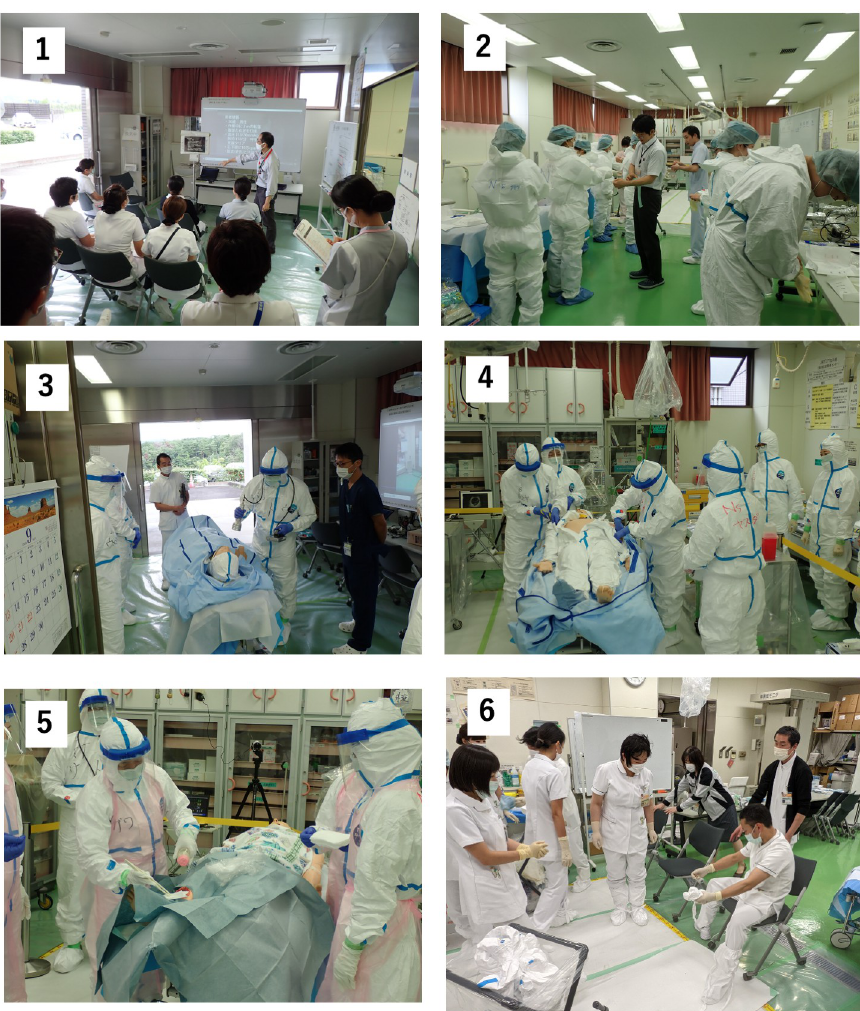
Fig 2. Seminar image of each process. (1) Lecture, (2) dressing in protective gear, (3) patient acceptance, (4) general medical treatment, (5) decontamination, and (6) undressing from protective